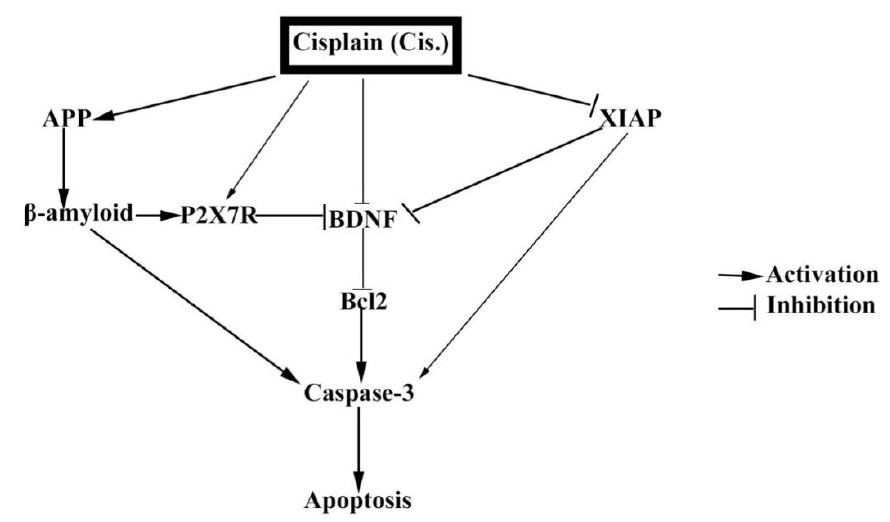
Figure 7. The mechanistic cascades of Cis induced brain apoptosis. The integration of possible mechanistic cascades of Cis induced brain apoptosis. Cis directly activates APP, β -amyloid and P2X7R. On the contrary, Cis can inhibit BDNF directly and indirectly via inhibiting XIAP. The decrease of DDNF is subsequently associated with the decrease of Bcl2, and so caspase-3 is activated and finally cerebral apoptosis is induced.